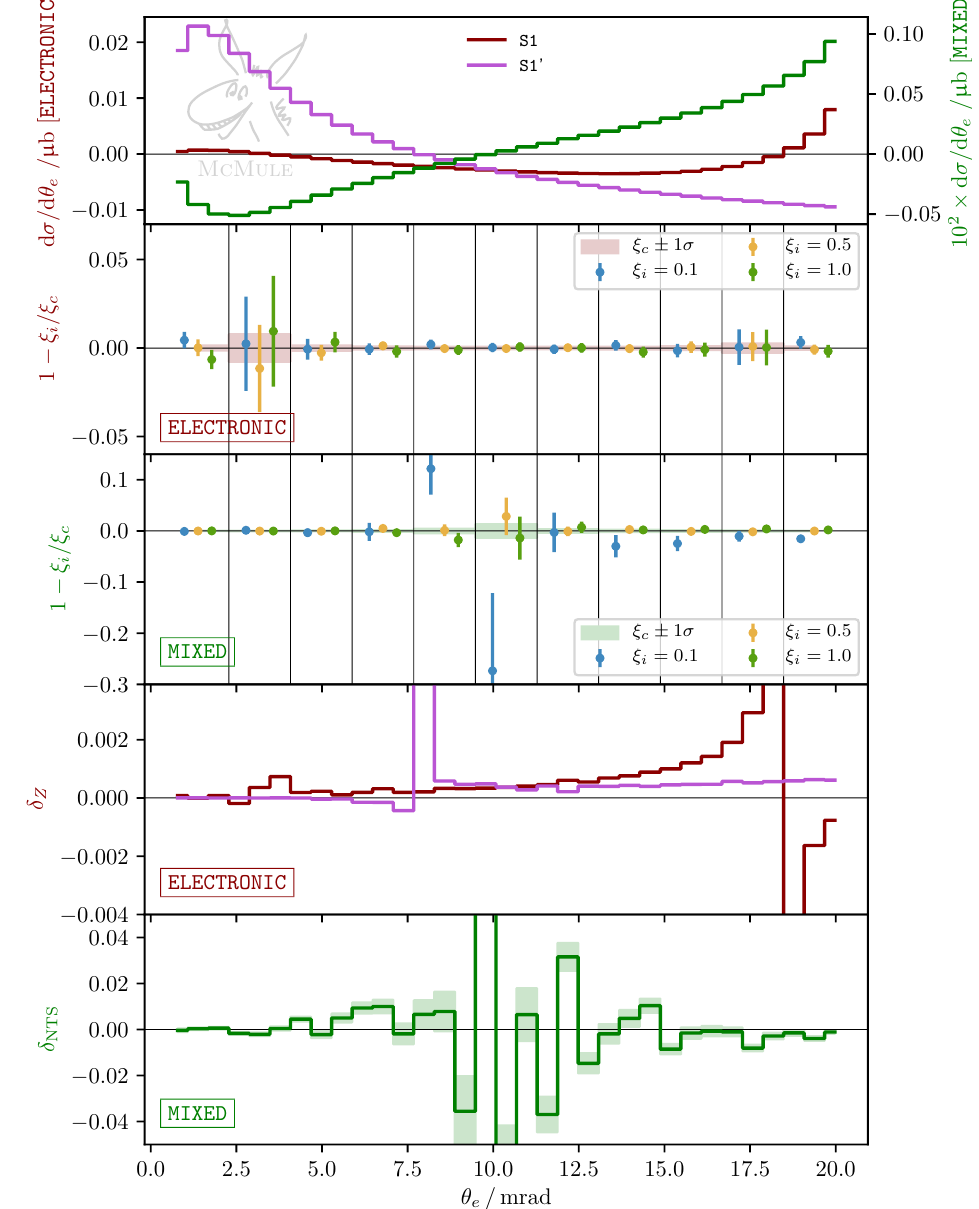
Figure 6 . Validation plots for electronic and mixed photonic corrections, as differential distribu- tions w.r.t. the electron scattering angle. From top to bottom (see the corresponding subsections in section 4 for further details): (i) differential NNLO correction w.r.t. θ e — electronic in S1 in red, electronic in S1 ’ in purple, mixed in S1 in green; (ii) ξ c -(in)dependence study for NNLO electronic corrections in S1 ; (iii) ξ c -(in)dependence study for NNLO mixed corrections in S1 ; (iv) massification study for NNLO electronic corrections — S1 in red, S1 ’ in purple; (v) NTS stabilisation study for NNLO mixed corrections. See (4.2) and (4.3) for details on δ Z and δ NTS